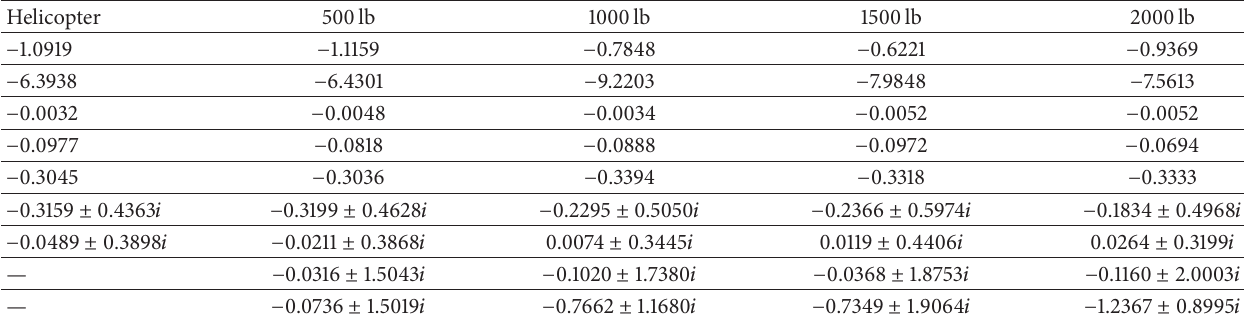
Table 1: System poles locations for a fixed slung length ( 𝑙 = 15 ft) but with different load weights.